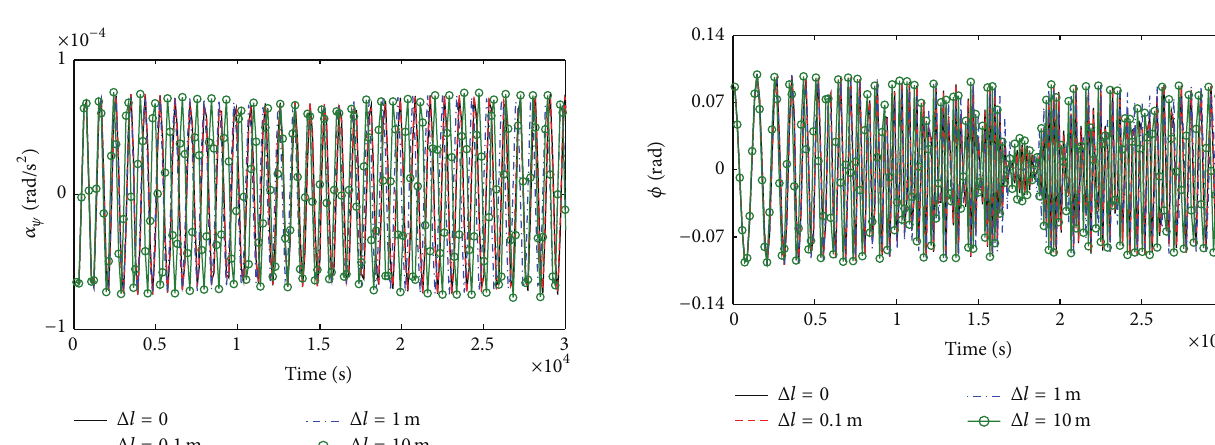
Figure 18: The time history of pitch angular acceleration with different Δ𝑙 , 𝜏 = 0 .